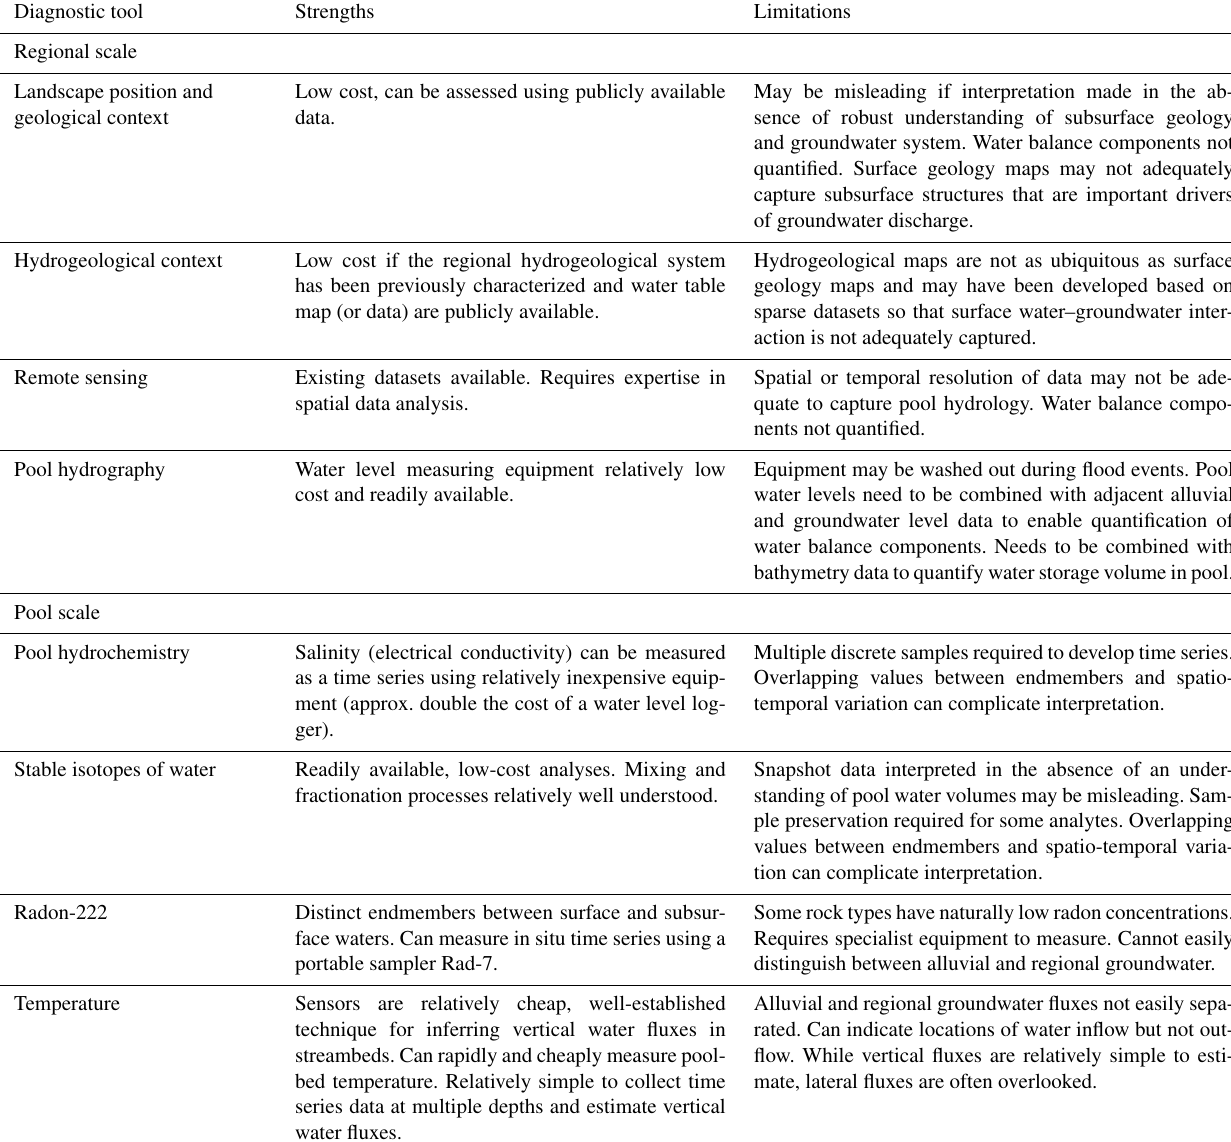
Table 2. Summary of pros and cons of available diagnostic tools for assessing the hydraulic mechanisms supporting persistent river